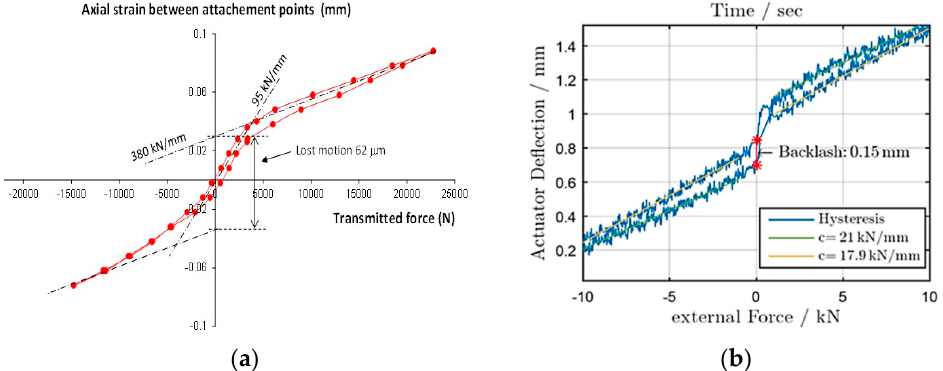
Figure 13. Examples of backlash measurements in EMAs: ( a ) Ground test EMA, direct-drive linear actuator with roller-screw, preloaded, rated force 50 kN [28]; ( b ) Demonstrator EMA sized for Airbus A320 aileron, gear-drive, ball-screw, no preload [29].